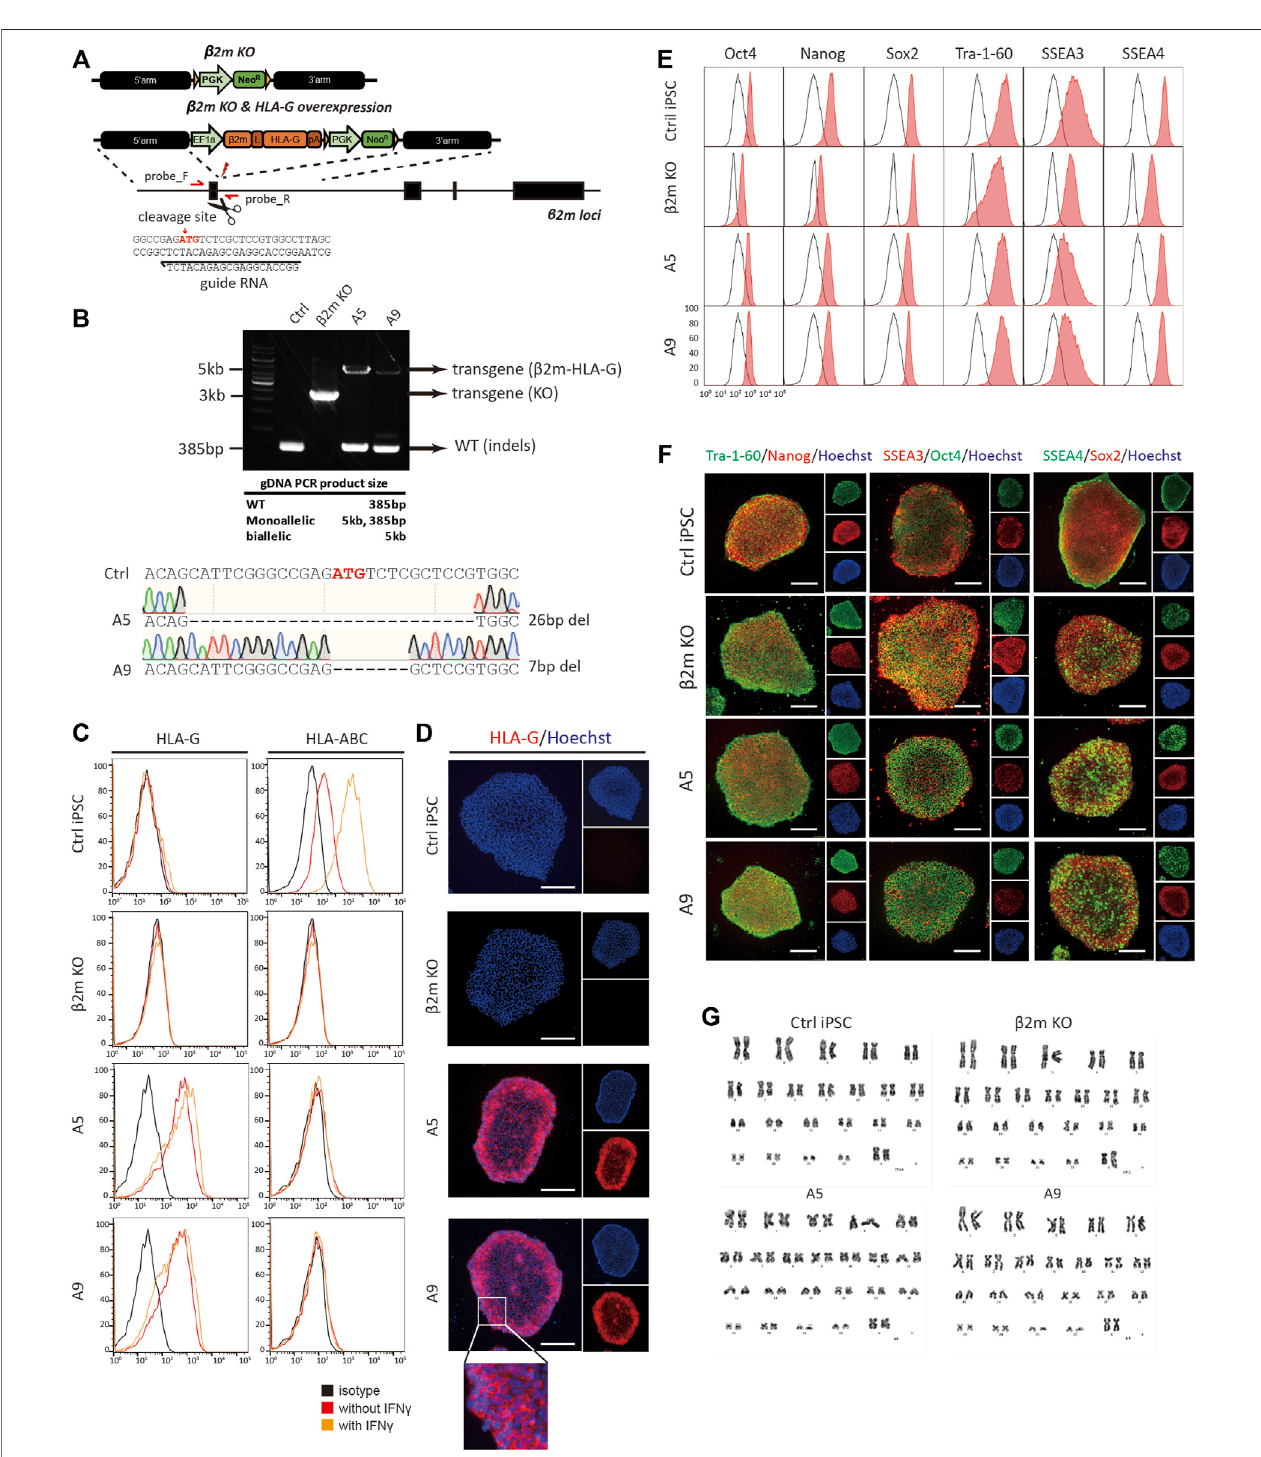
FIGURE 2 | Generation and characterization of hypoimmunogenic cell lines. (A) Schematic of the donor plasmid for homology-directed repair and the gRNA sequence used for gene editing. (B) Genotyping of cell lines by conventional PCR. Indels at target loci were sequenced by the Sanger method. (C) Flow cytometric analysisofsurfacephenotype.HLA-GandHLA-BCexpressionpatternswith(orange)orwithout(red)IFN- γ incontrol(CtrliPSC), β 2mknock-out( β 2m-KO),andHLA-G- overexpressing cell lines (A5 and A9) and the isotype control (black). (D) Immunocytochemistry of surface HLA-G expression; all images are fl uorescence micrographs. (E,F) Characterization of pluripotency markers by fl ow cytometry and immunocytochemistry. (G) Karyotyping by GC-banding. Scale bar, 250 μ m.